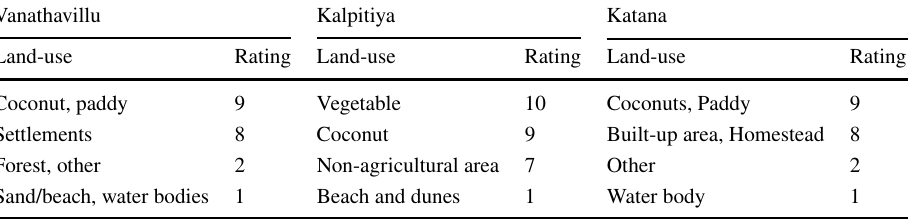
Table 6 Ratings of the land-use layer with the highest assigned weight of